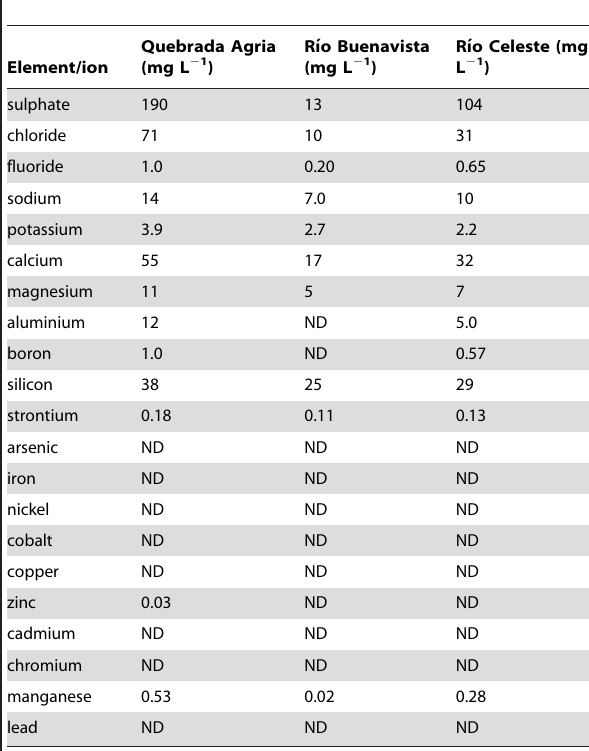
Table 2. Chemical composition/ppm of Rı´o Buenavista, Quebrada Agria and Rı´o